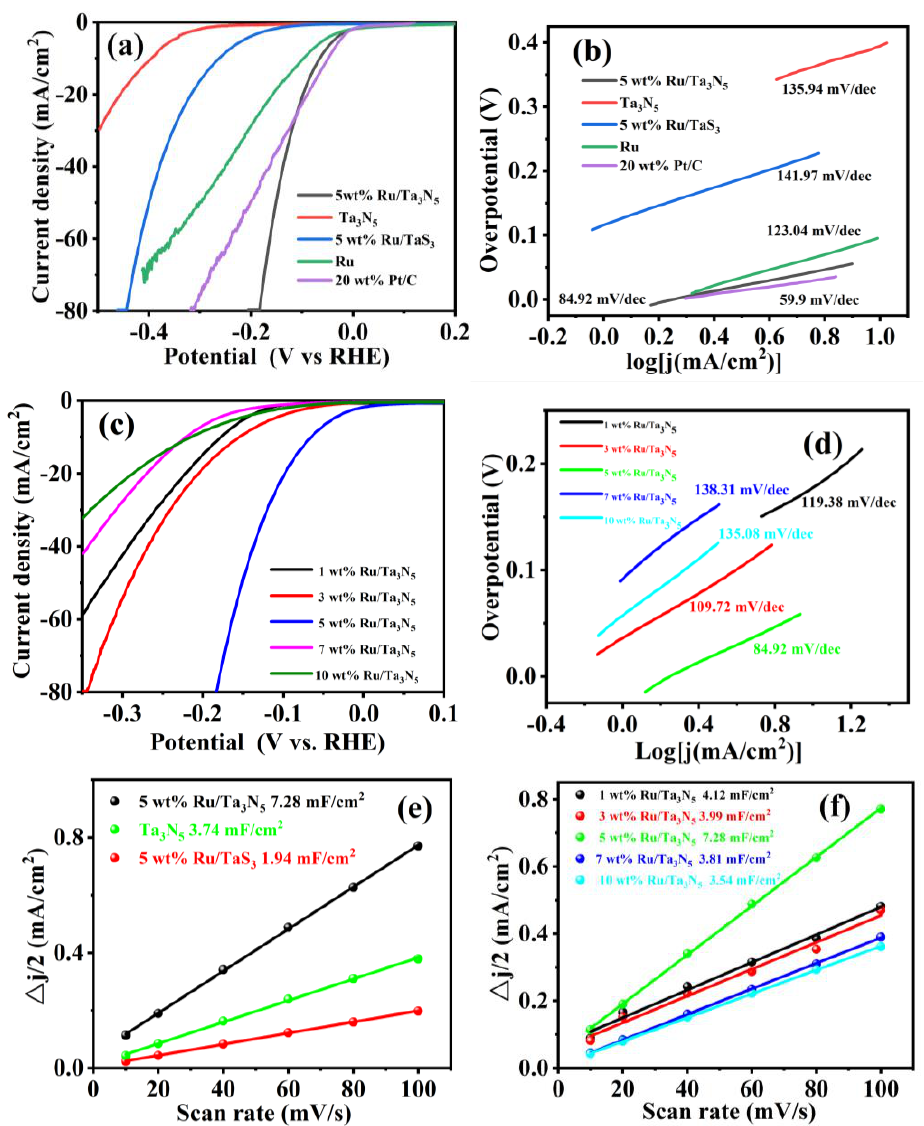
Figure 5. ( a ) LSV and ( b ) Tafel curves of 5 wt% Ru/Ta 3 N 5 NBs, Ta 3 N 5 NBs, 5 wt% Ru/TaS 3 NBs, and Ru (5 wt% Ru/C); ( c ) LSV and ( d ) Tafel curves of 1 wt%, 3 wt%, 5 wt%, 7 wt%, and 10 wt% Ru/Ta 3 N 5 Ru (5 wt% Ru/C); ( c ) LSV and ( d ) Tafel curves of 1 wt%, 3 wt%, 5 wt% , 7 wt%, and 10 wt% Ru/Ta 3 N 5 NBs; ( e ) ΔJ/−v curves of 5 wt% Ru/Ta 3 N 5 NBs, Ta 3 N 5 NBs, and 5 wt% Ru/TaS 3 NBs; ( f ) ΔJ/2−v curves NBs; ( e ) ∆ J/ − v curves of 5 wt% Ru/Ta 3 N 5 NBs, Ta 3 N 5 NBs, and 5 wt% Ru/TaS 3 NBs; ( f ) ∆ J/2 − v of 1 wt%, 3 wt%, 5 wt%, 7 wt%, and 10 wt% Ru/Ta 3 N 5 NBs. curves of 1 wt%, 3 wt%, 5 wt%, 7 wt%, and 10 wt% Ru/Ta 3 N 5